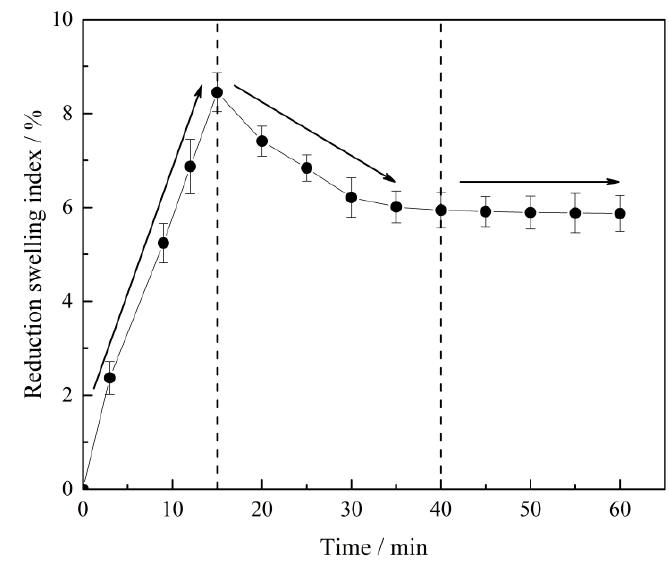
Figure 14. Effect of time on the reduction swelling index of CVTP.